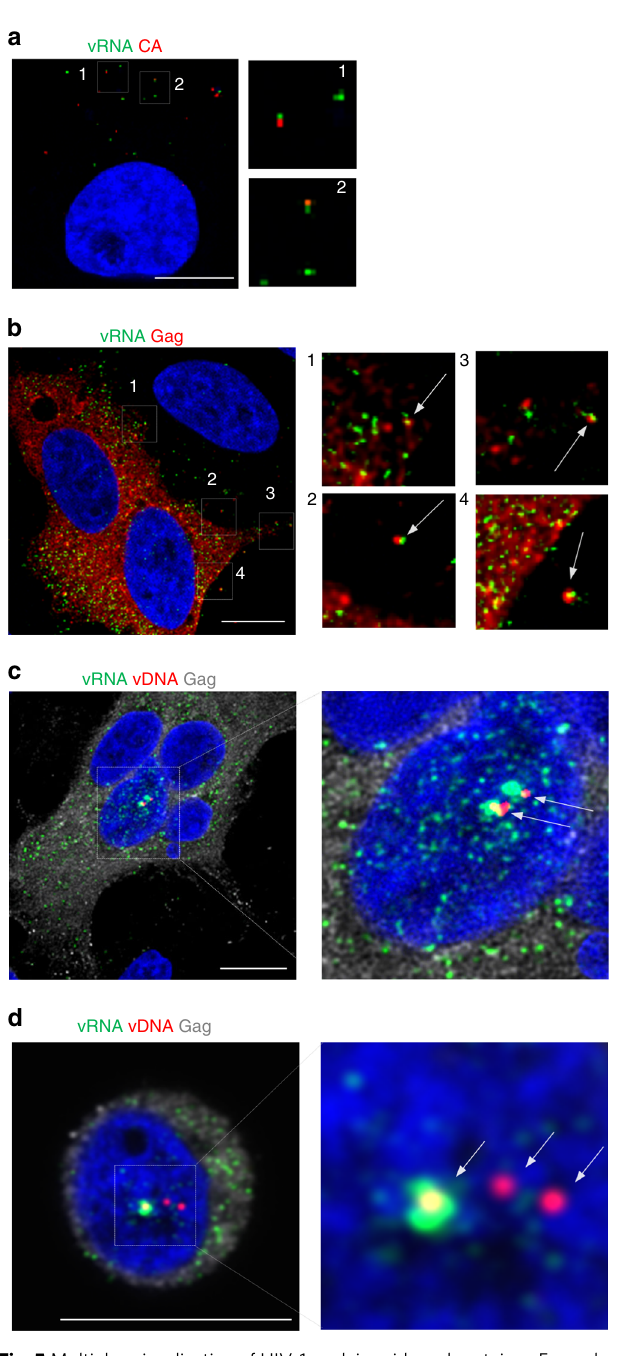
Fig. 5 Multiplex visualization of HIV-1 nucleic acids and protein. a Examples of colocalized vRNA and capsid (CA). TZM-bl cells were infected with HIV- 1 at an MOI of 0.2; at 2 hpi cells were fi xed and stained for unspliced vRNA (PS-1; green), CA (red) and nuclei (blue). Enlarged images indicate co- localization between genomic vRNA of incoming virus and CA. b Apparent formation of nascent virions. TZM-bl cells were infected with HIV-1 at an MOI of 0.2; at 24 hpi cells were fi xed and stained for vRNA (PS-1; green), Gag (red), and nuclei (blue). Arrows indicate putative virions. c Multiplex visualization of transcribed vRNA (PS-2; green) from vDNA (PS-3; red, indicated by white arrows) and of translated Gag (gray). TZM-bl cells were infected with HIV-1 at an MOI of 2; at 30 hpi cells were fi xed and stained. d Discordant expression from nuclear vDNA sites. Jurkat cells were infected with HIV-1 at an MOI of 2; at 24 hpi cells were fi xed and stained for vRNA (PS-2; green), vDNA (PS-3; red, indicated with white arrows), Gag (gray), and nuclei (blue). Images were captured with an LSM 880 confocal microscope. Scale bars represent 10 µ